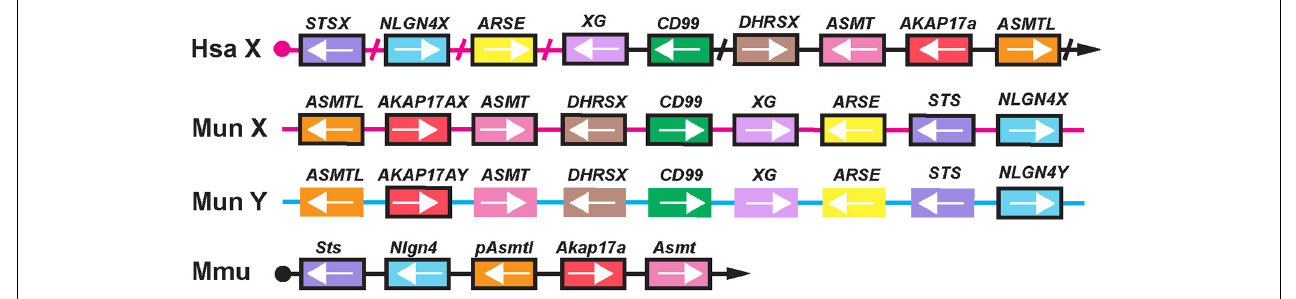
FIGURE 6 | X- and Y-chromosomal sequences display loss of their pseudoautosomal character in gerbils. A schematic illustrates the presence of those genes that have been identified to comprise the genes of the pseudoautosomal region in the laboratory mouse (Mmu, Maxeiner et al., 2020), genes present in the vicinity of NLGN4X and NLGN4Y in gerbils (Mun X and Mun Y), as well as the homologs on the X-specific and pseudoautosomal region on the human X chromosome (Hsa X). The magenta line indicates that STSX , NLGN4X , ARSE and parts of XG are located on the X-specific part of the human X-chromosome, all other genes are pseudoautosomal. Arrowheads direct toward the telomeres. Slashes are marking gaps in the human sequence comprising genes irrelevant for this comparison. In laboratory mice, six genes are localized to the pseudoautosomal region. The Erdr1 gene upstream of Sts is not shown since it is only present in mice. Comparison of human and mouse genes with those present on the gerbil X and Y chromosomes reveal that both neuroligin-4 gametologs share a similar vicinity. The gerbil Y-chromosomal sequence retains NLGN4Y and AKAP17AY as likely functional genes. The remaining genes display various mutations and have become subject to pseudogenization. Pseudogenes are presented in unframed boxes; framed boxes resemble genes with potential expression based on the presence of an intact reading frame. The results are based on sequence comparison between VFHZ01026354.1 (Mun X) and VFHZ01013942.1 (Mun